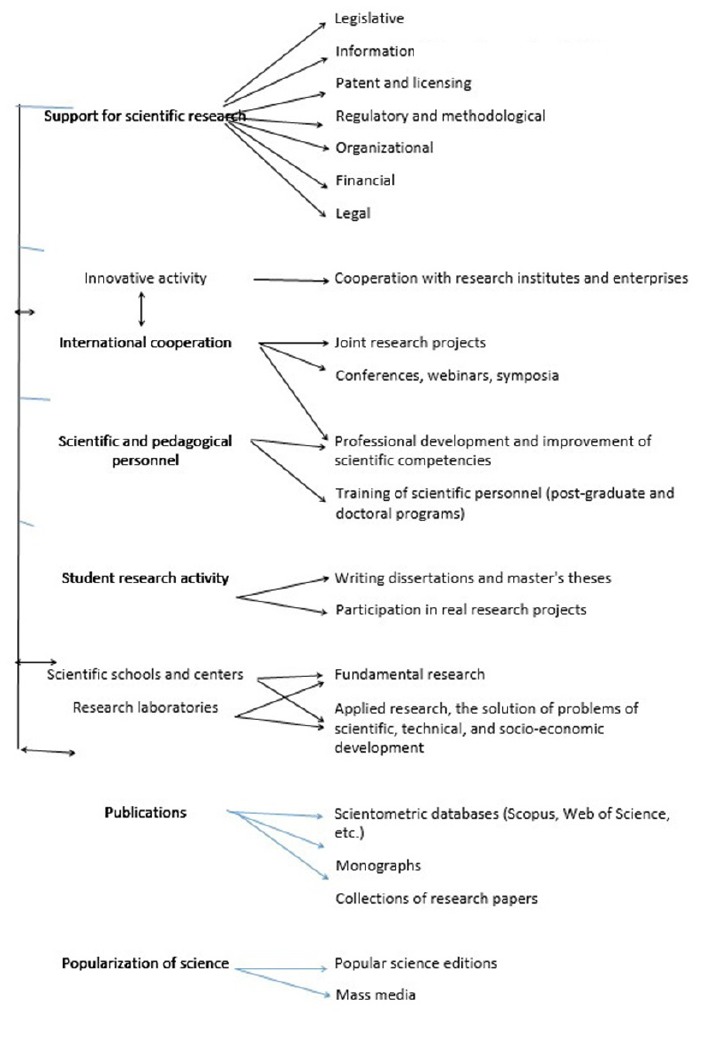
Fig. 3. Conceptual model of the system of scientific and